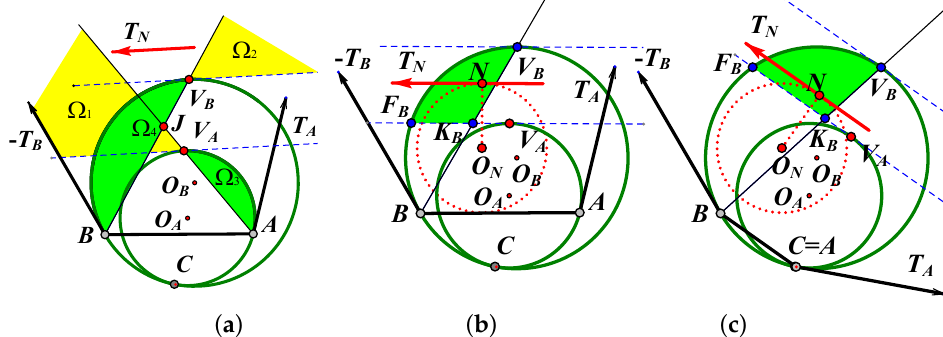
Figure 11. Inserting the first new data set { N , T N , O N } when C / ∈ G and C is on both curvature